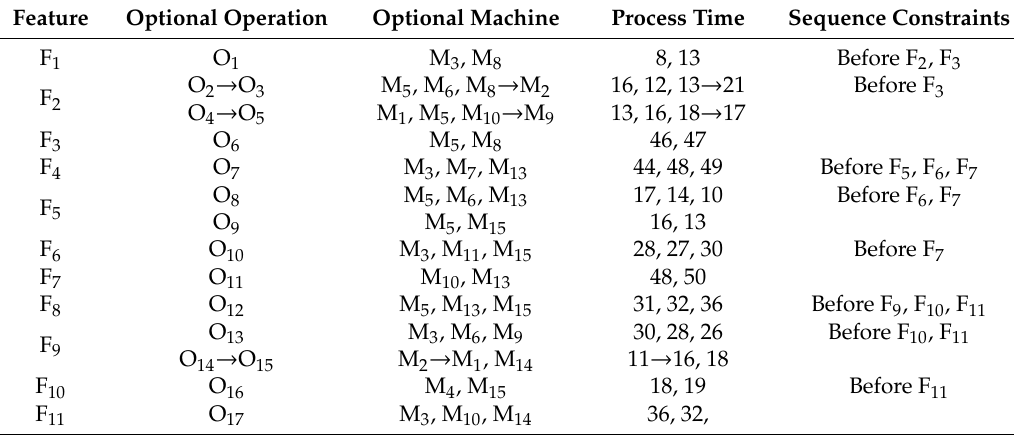
Figure 13. The AND/OR network of the product in case 1. Figure 13. The AND / OR network of the product in case 1. Table 3. The process information of the product in case 1.